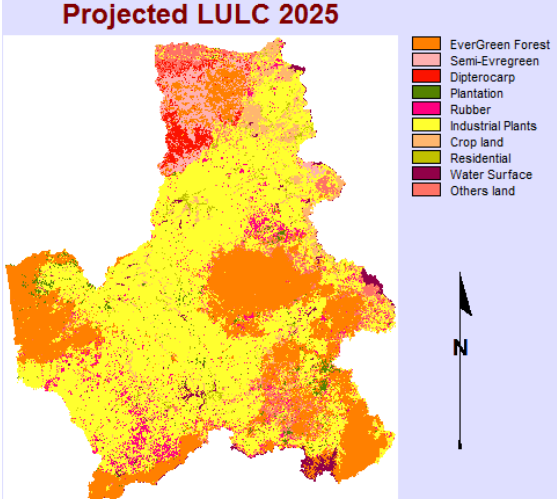
Figure 4. MLP_Markov model projected the LULC scenario of Dak Nong